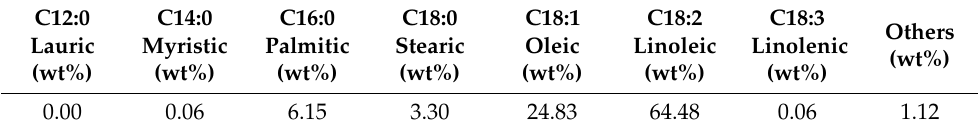
Table 1. Sunflower oil fatty acid